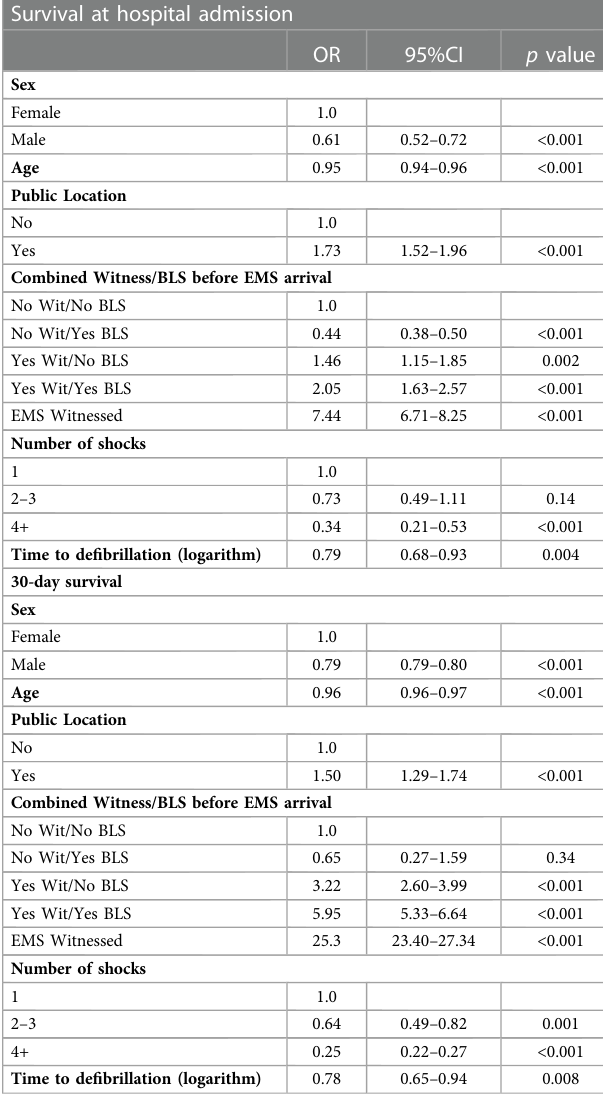
TABLE 5 Multivariable logistic regression analysis to assess predictors of survival at hospital admission and at 30 days. Survival at hospital